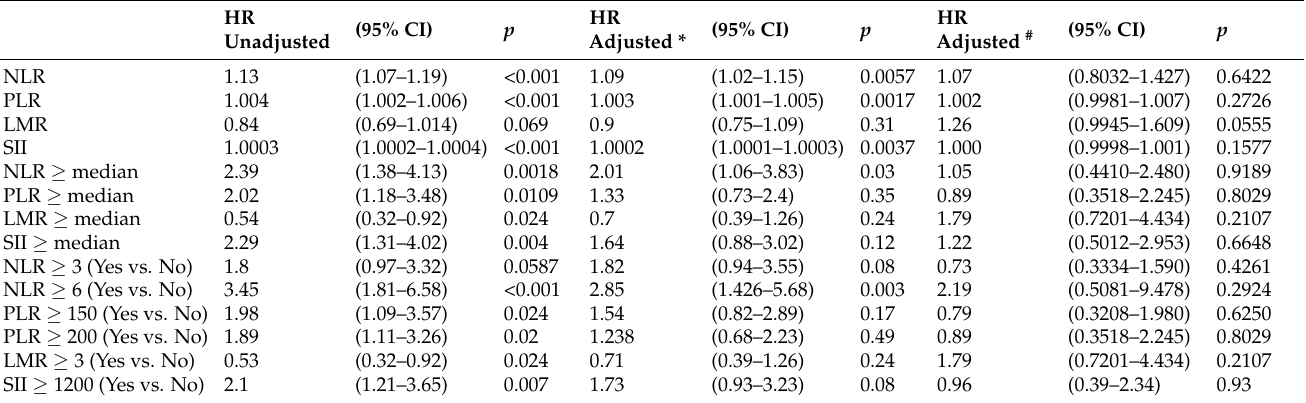
Table 2. Univariate and multivariate Cox proportional hazard regressions on subjects with Klatskin tumor adjusted for age, procedure, resection margin, and TMN